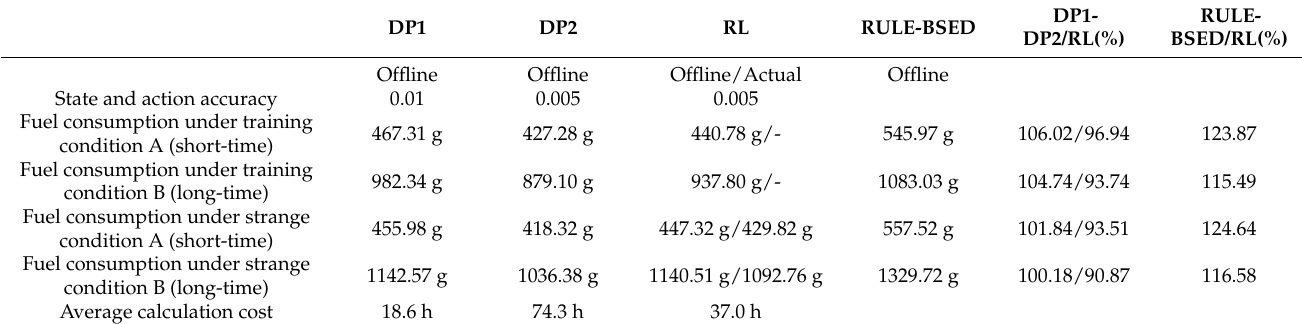
Table 6. Comparison of application effects of different control strategies.